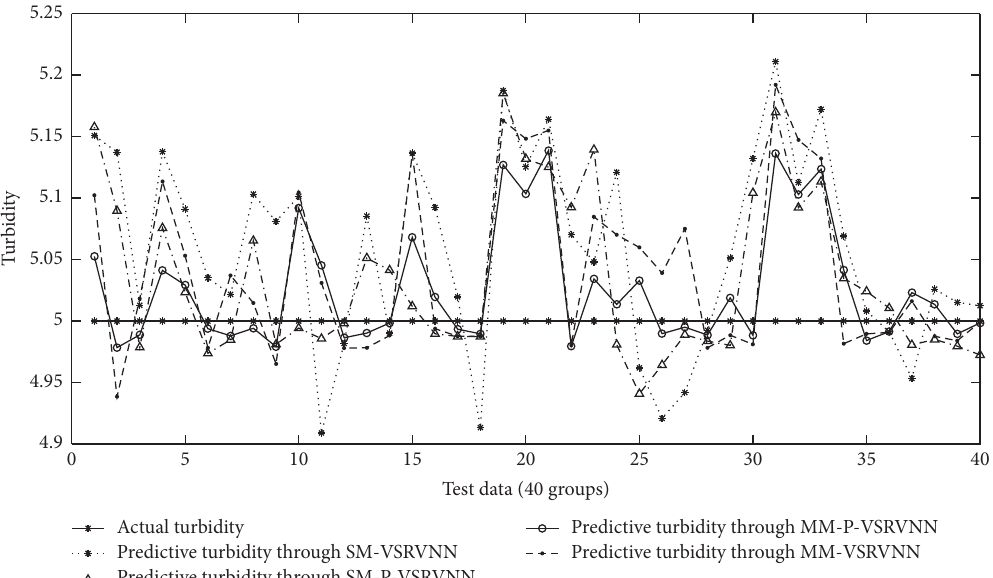
Figure 9: Prediction output for turbidity before filtration with four different